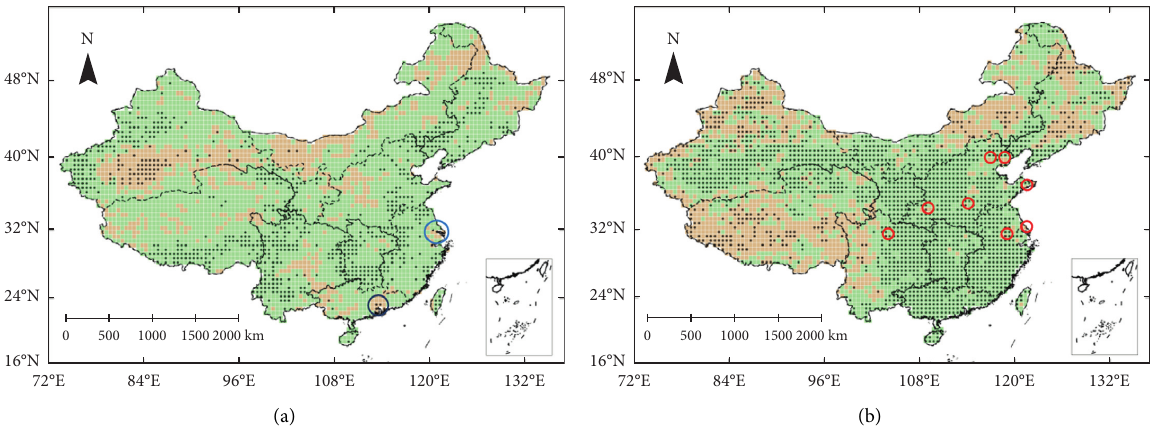
Figure 7: Spatial distribution of RESTREND /NDVI during (a) 1982–1998 and (b) 1999–2015 in China. The solid circle denotes a NDVI /NDVI, green (brown) shading indicates an improvement (degradation) in vegetation, the significant ( p < 0 . 05) change in RESTREND NDVI blue circles indicate vegetation degradation areas (1982–1998) in the Pearl River Delta and Yangtze River Delta, and the red circles indicate vegetation degradation areas (1999–2015) in megacities from west to east: Chengdu, Xi’an, Zhengzhou, Beijing, Tianjin, Nanjing, Qingdao, and